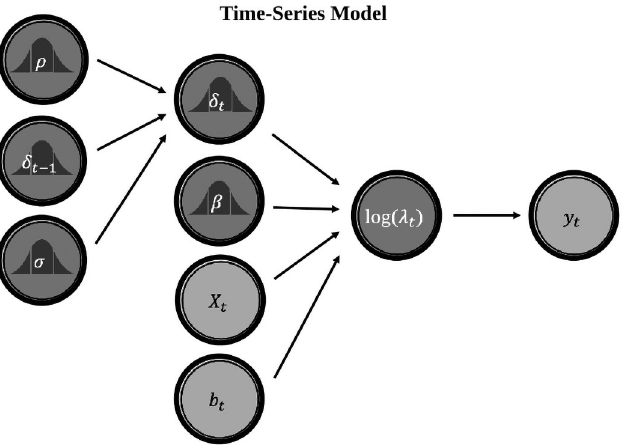
Fig 3. Directed acyclic graph for the time-series model. In this image, Light grey circles represent data— y t refers to conflicts dated to a given time; X refers to a matrix of covariates; and b is the number of monuments dated to a given t t time. Dark grey circles represent terms estimated from the data (see 1–7). The dark grey density symbols indicate probabilistic terms, and terms without subscripts are non-time varying.